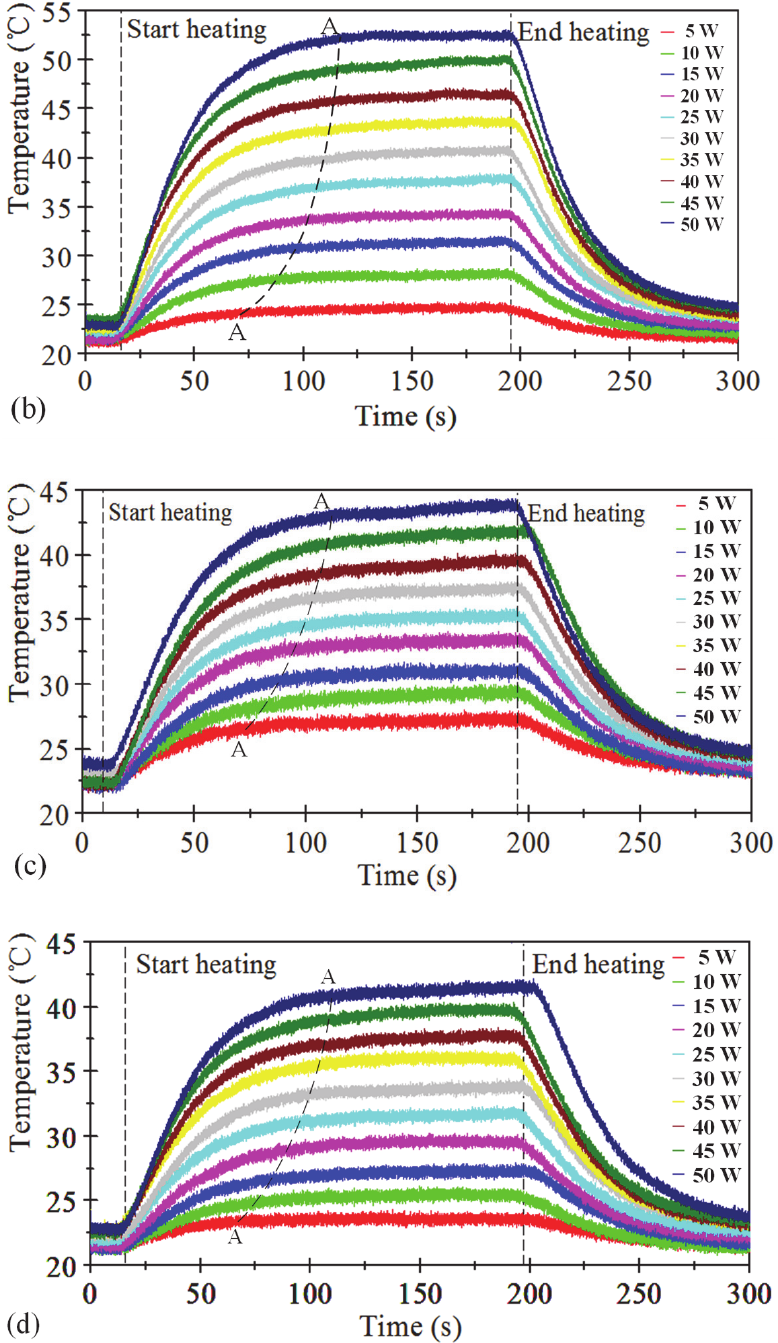
Figure 6. Temperature outside the evaporator of the heat sink under different heat inputs for different cases of ( a ) single THP with 0 ◦ ; ( b ) single THP with 90 ◦ ; ( c ) double THPs with 0 ◦ ; ( d ) double THPs with 90 ◦